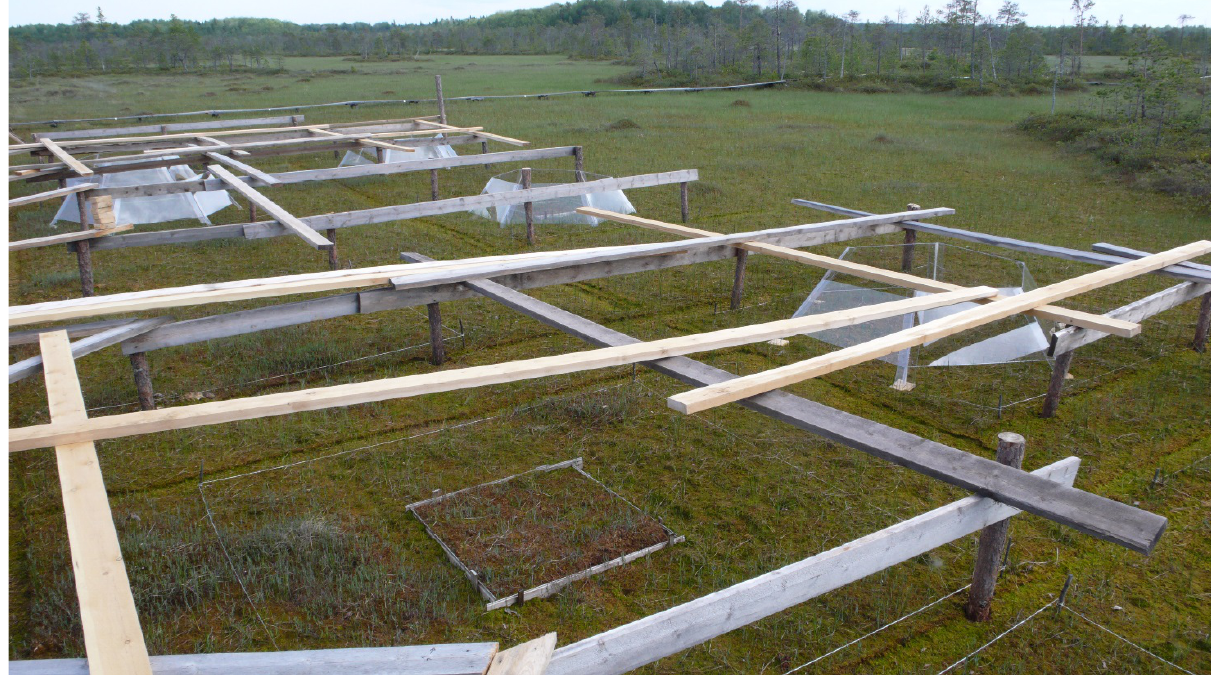
Figure 8. Mukhrino Mire experimental site. The Linje Mire (Poland) experimental design was applied at this peatland in Western Siberia (Russia) in 2013 (photo Alexandre